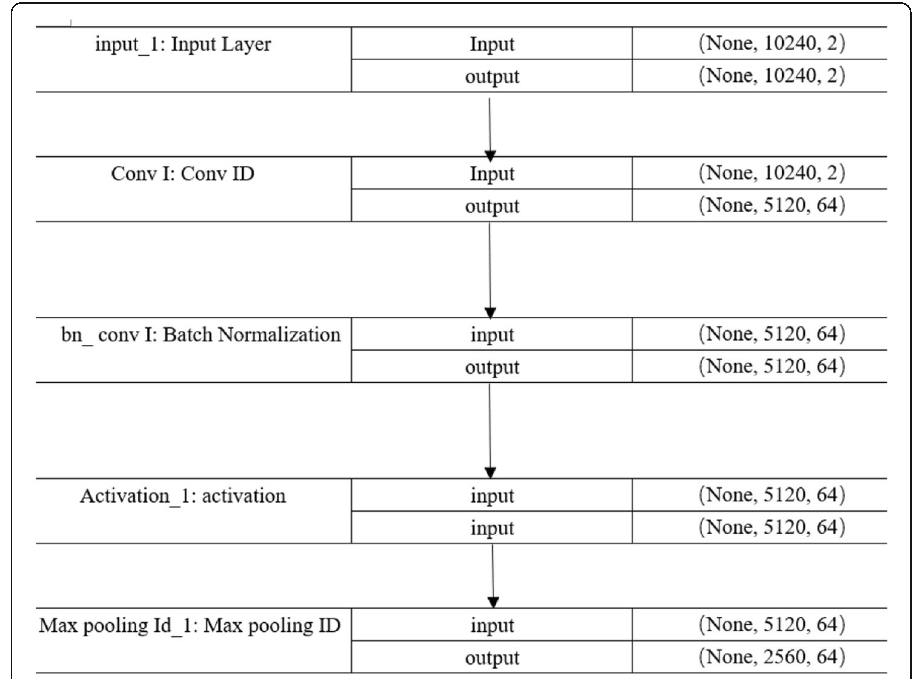
Fig. 7 Detailed network structure of the first phase of